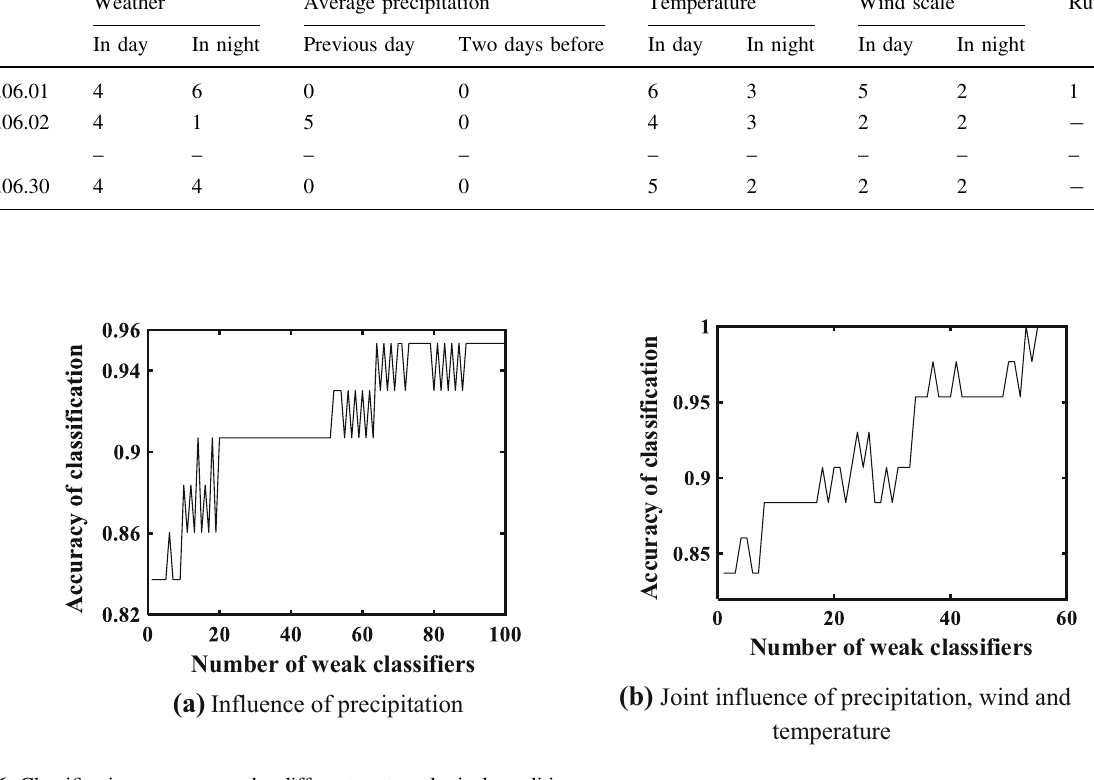
Fig. 6 Classification accuracy under different meteorological